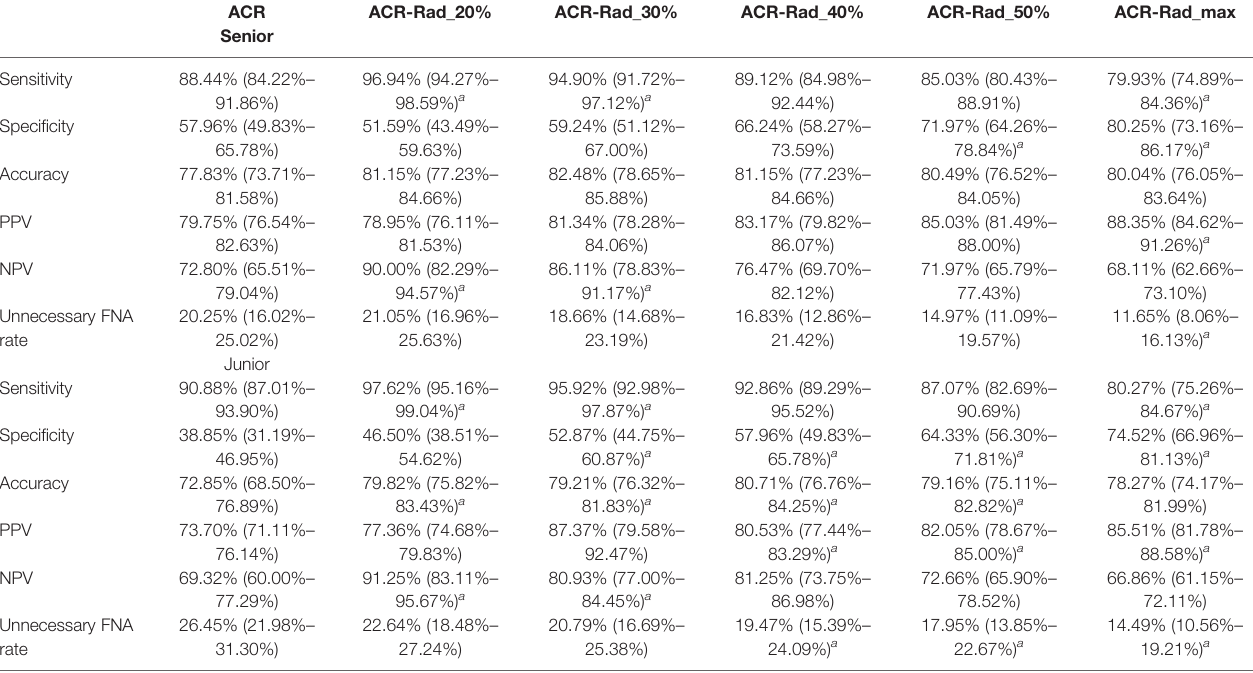
TABLE 5 | Diagnostic performance and unnecessary FNA rates of ACR TI-RADS and risk cutoff values for the ACR-Rad